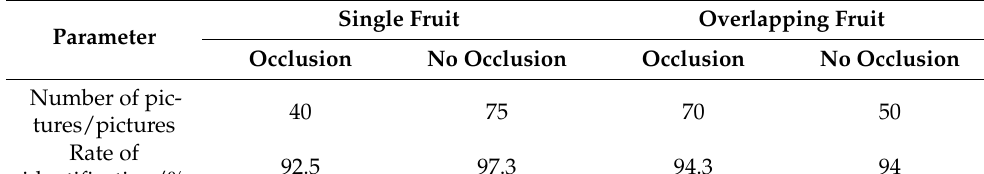
Table 5. Model recognition effect in a complex environment.